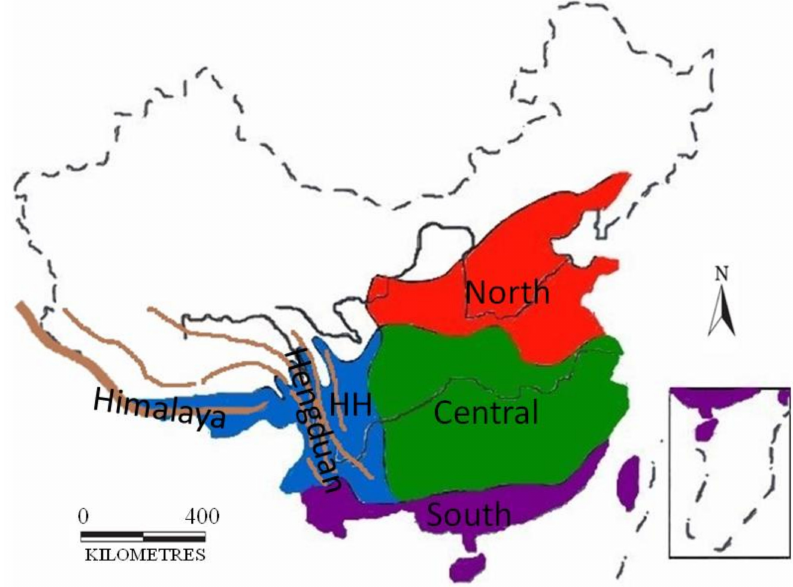
Figure 1. Four biogeographic units: HH, Himalaya-Hengduan Mountains Region; South, Southern China Region; Central, Central China Region; and North, Northern China